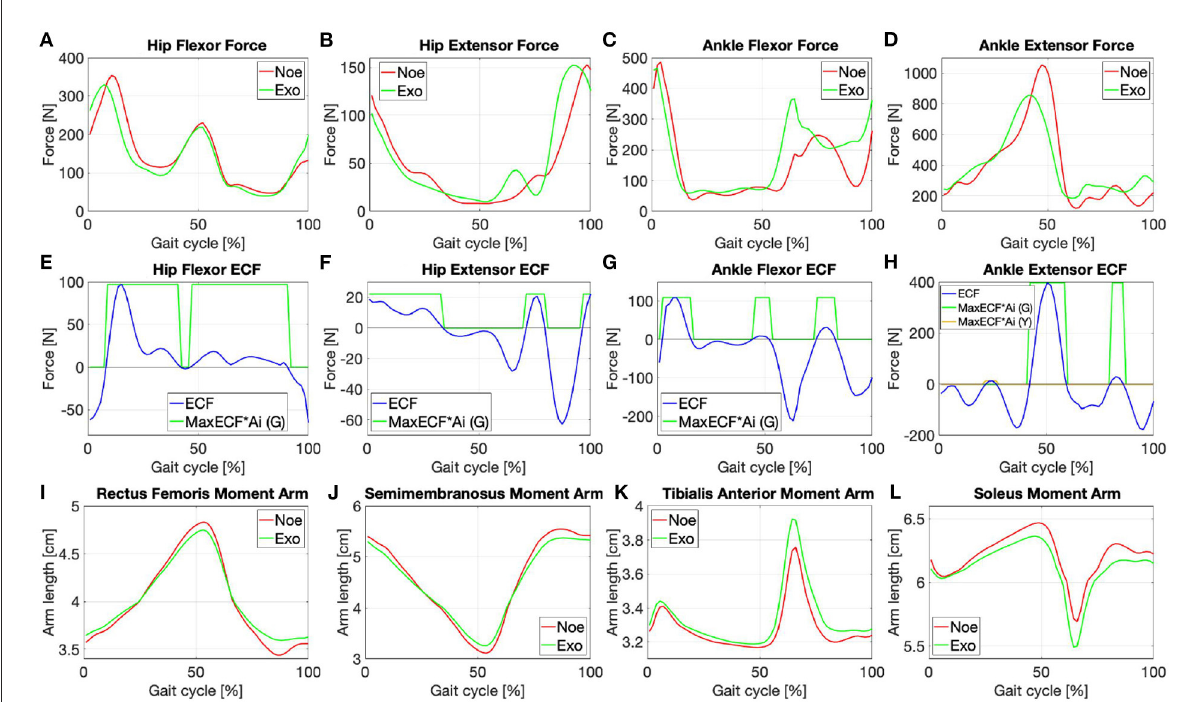
FIGURE3 Force signals of the (A) rectus femoris, (B) semimembranosus, (C) tibialis anterior, (D) gestrocnemius medialis in the Noe (red) and Exo (green) configurations; the ECF of each muscle with the associated AsIx multiplied with a gain factor to be more easily viewable (E–H) ; moment arms in the Noe (red) and Exo (green) configurations needed to calculate the torque generated by each muscle (I–L)